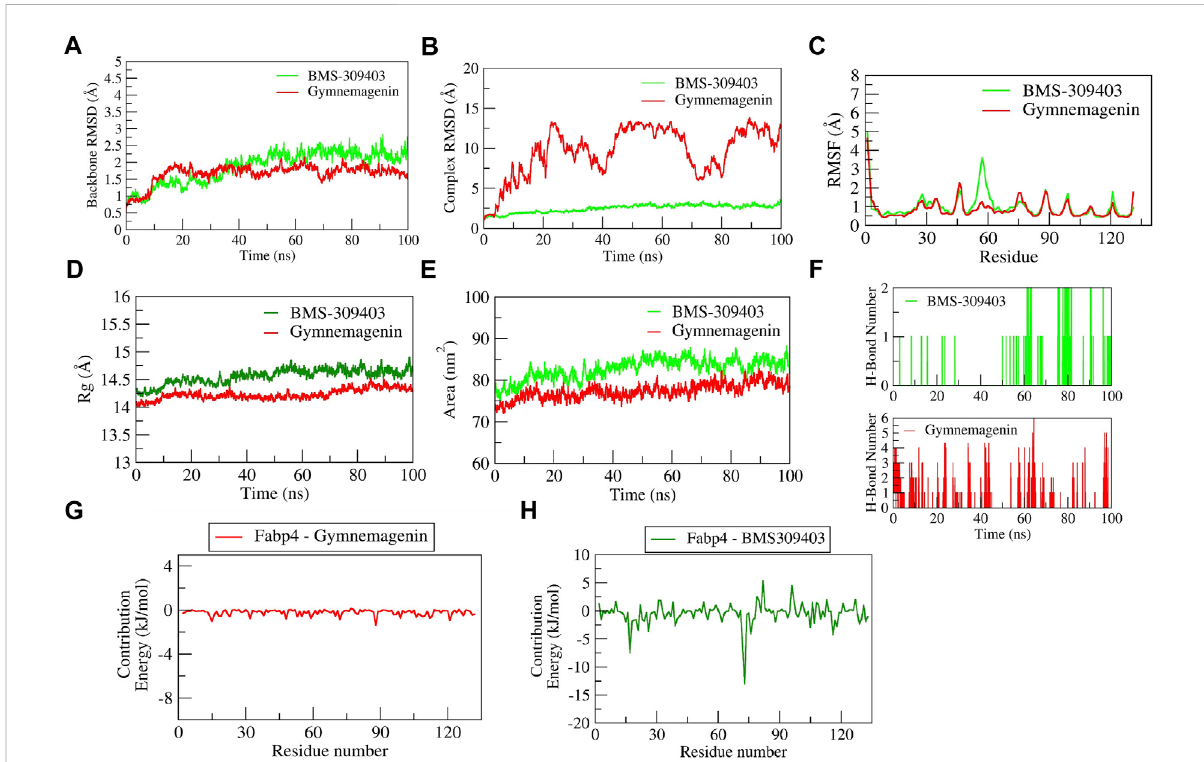
FIGURE 11 Parameters describing gymnemagenin and BMS-309403 – Fabp4 complex structural stabilities. (A) RMSD of backbone, (B) RMSD of complex, (C) RMSF, (D) Rg, (E) SASA, (F) numberofH-bondinteractions, (G,H) per-residue contribution energyplothighlighting theimportanceofthebinding pocket residues in stable complex